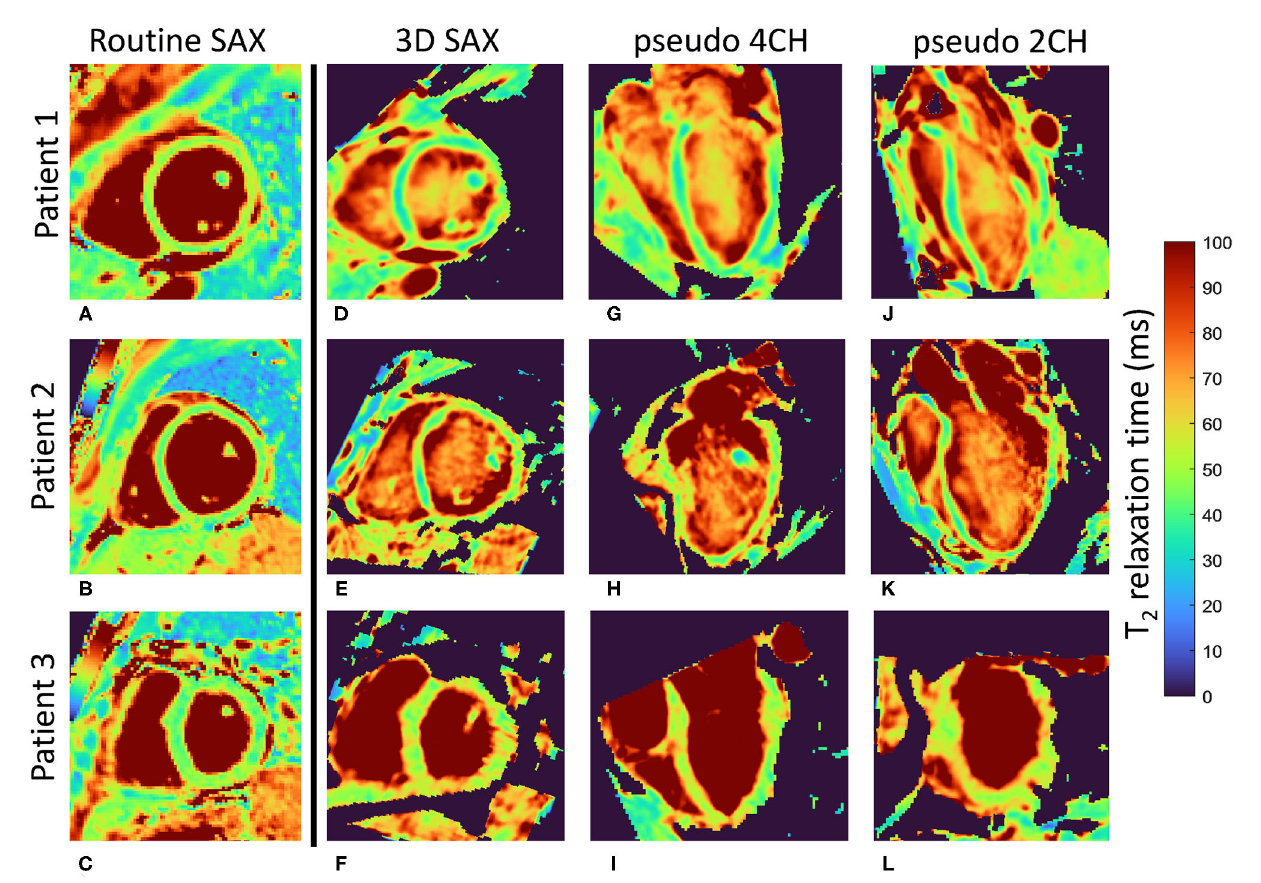
FIGURE 4 | Motion-registered 3D T 2 maps of the heart of three patients. (A–C) Routine T 2 -prepared 2D bSSFP short-axis (SAX) T 2 maps. (D–F) Matching single slices from the motion-registered 3D T 2 maps; T 2 values closely match those of the routine maps. (G–L) Perpendicular long-axis (LAX) maps from the same 3D datasets as in (D–F) . Patient 1 (female, 37 y.o.) and patient 2 (male, 44 y.o.) had myocarditis, while patient 3 (male, 65 y.o.) had sarcoidosis. Local minor T 2 fluctuation can be observed in all three orientations of the 3D T 2 maps and all three patients, and might be caused by small misregistrations, as well as by local T 2 variations that show up in the 1.6 mm-thick 3D slice, but are averaged out in the 8 mm-thick 2D slice. However, global T 2 values did not significantly differ in any of the patients. The color bar shows the T 2 relaxation time in